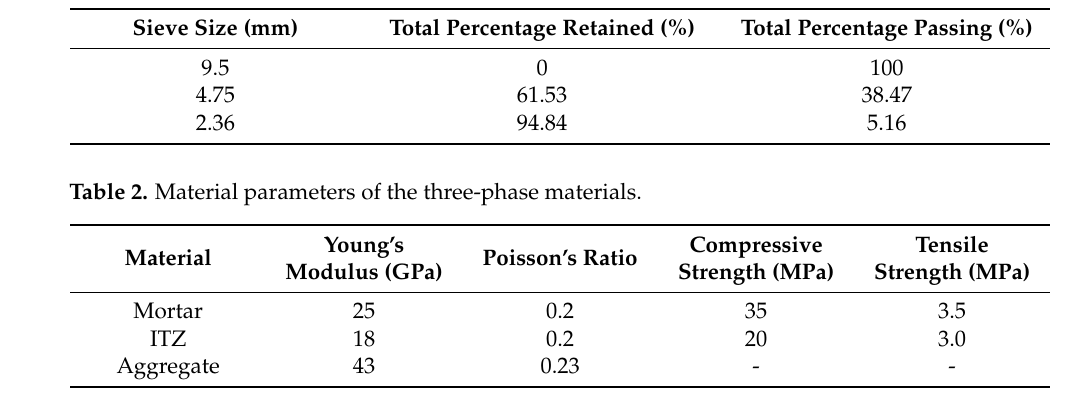
Table 1. Size distribution of the aggregates.